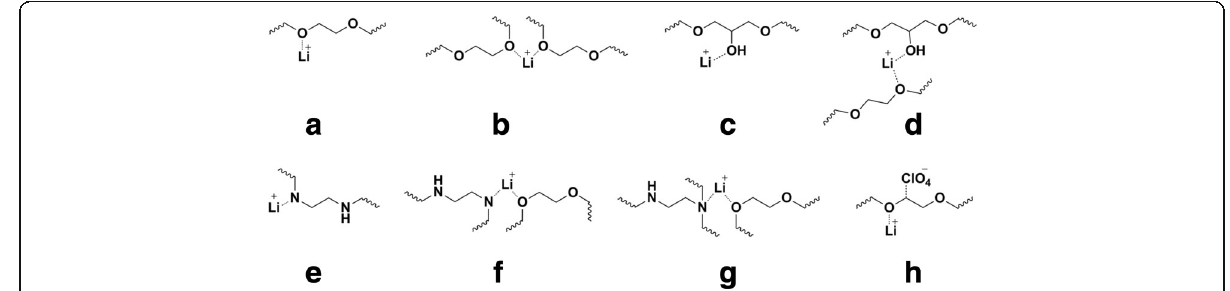
Fig. 4 a – h Schemes of complexes. Complexes which possibly exist in the systems LiClO 4